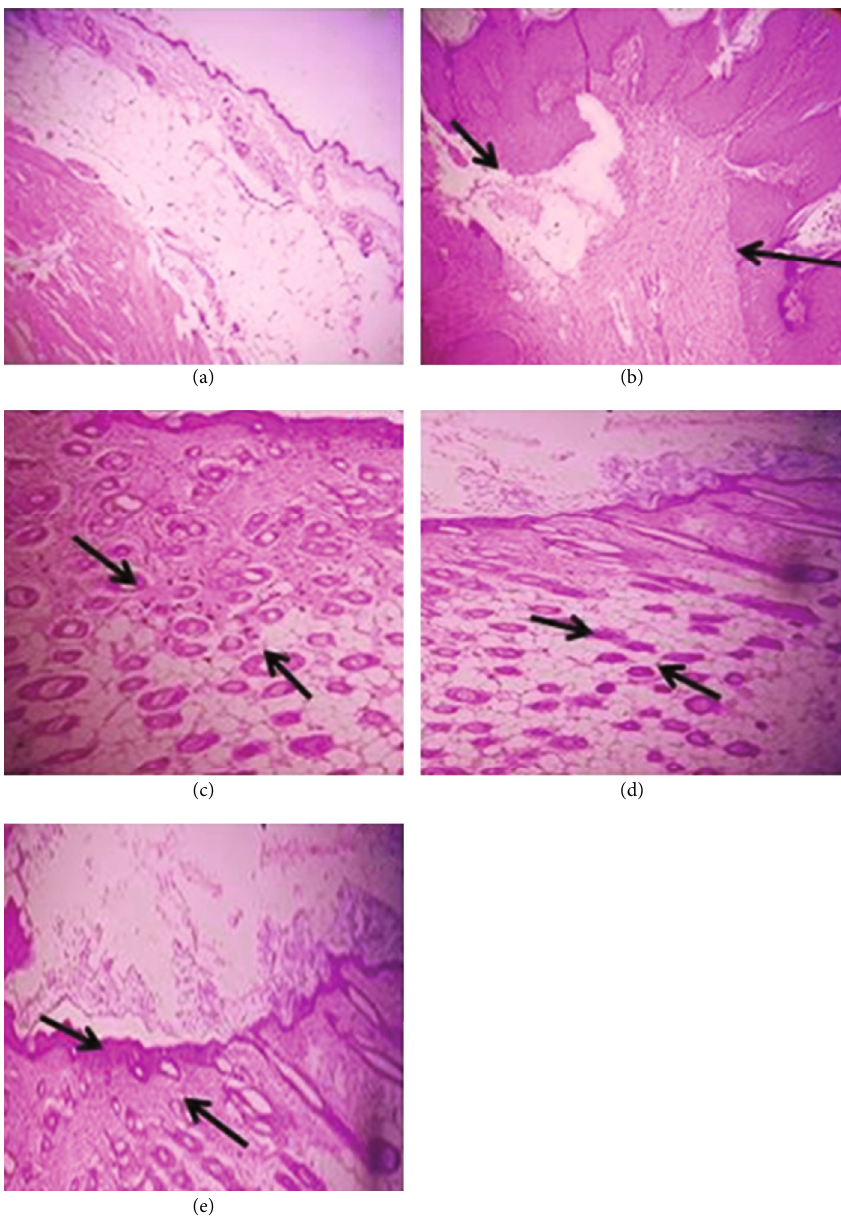
Figure 10: (a – e) Histological evaluation of skin tissue corresponding untreated, DMBA-induced group, FA-treated group, and positive control (The DMBA induced the degenerated cervical patches of the skin of mice; it was brought to normal by FA-treated